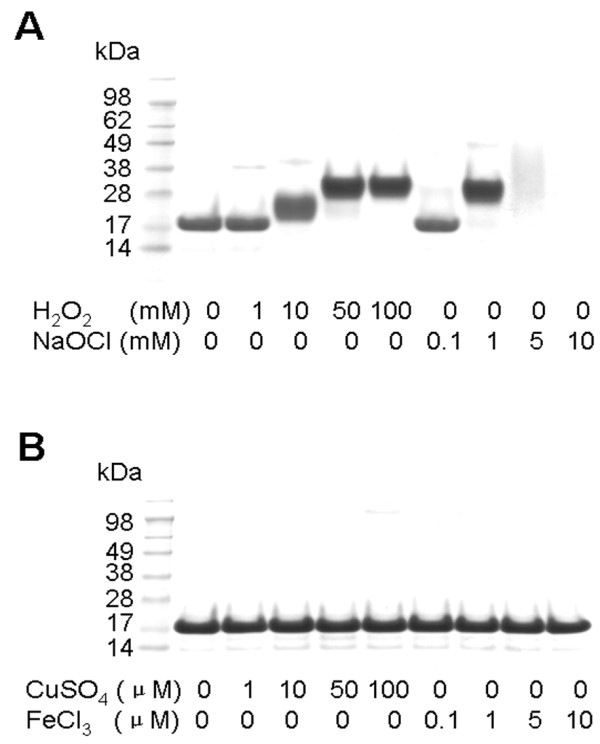
Oxidation of Met in MRPs by various oxidants. 20 μM MRP5 was oxidized with the indicated concentrations of (A) hydrogen peroxide (H2O2) or sodium hypochlorite (NaOCl) at 37°C for 1 h; (B) CuSO4 or FeCl3 at 37°C for 2 h, and then subjected to SDS-PAGE analysis.